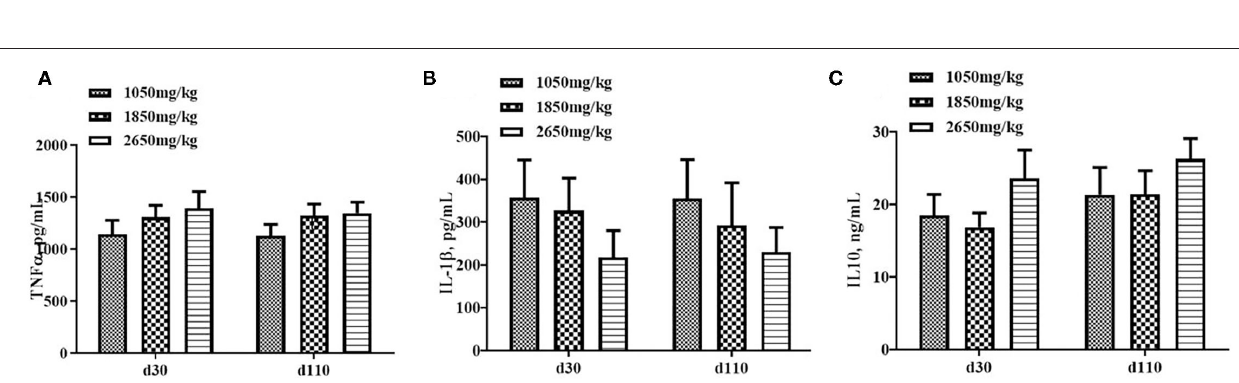
Frontiers in Veterinary Science |